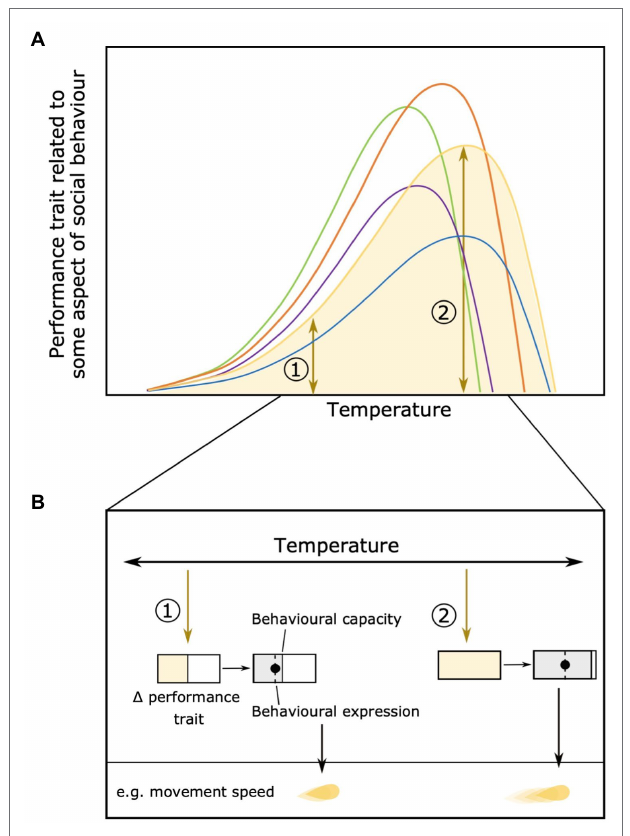
FIGURE 4 | Change in within-individual variation across an environmental gradient (e.g., temperature). The area below the performance curve indicates the variation in individual performance [ (A) , individual in yellow used as an example]. Differences in individual variation in performance trait at two different temperatures [1 and 2 (B) ] can result in different behavioral capacity and expression. For example, at temperature 1 the yellow individual has only little variation in performance and its behavior is only expressed as low movement speed, while at temperature 2 (close to its optimum) the same individual has a higher variation of movement and can move up to very high speeds. Panel (B) reproduced from Jolles et al.